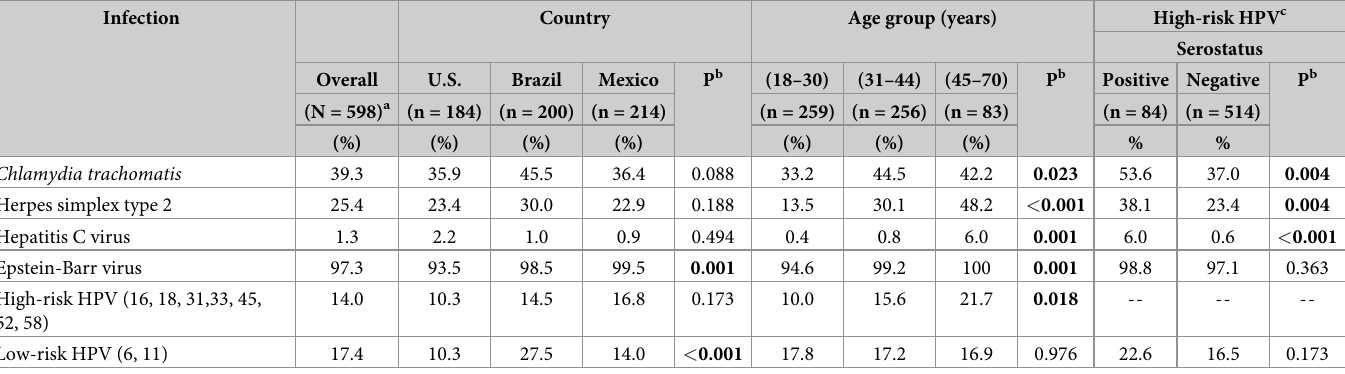
Table 1. Seroprevalence of Chlamydia trachomatis , herpes simplex type 2, hepatitis C, and Epstein-Barr virus by country, age and high-risk HPV antibody